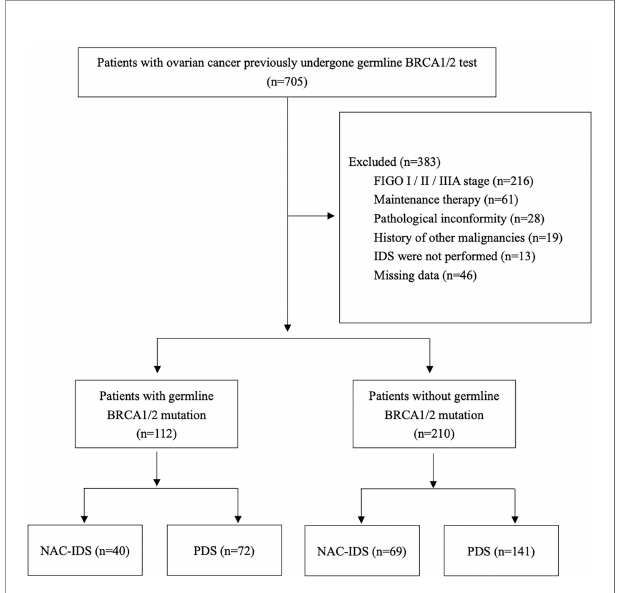
FIGURE 1 | The fl owchart of this